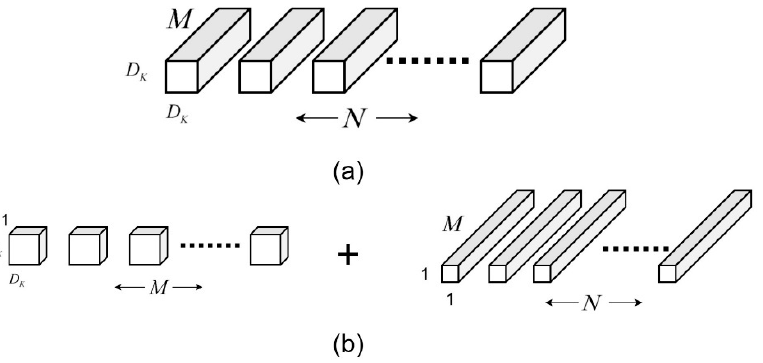
Figure 1. Depthwise convolution separable. (a): Standard convolutional filters (b): Depthwise con- volutional filters